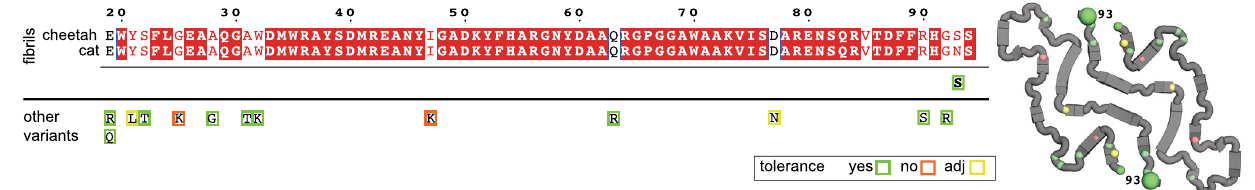
Fig. 5 | Cheetah and cat AA amyloid are 99% identical. Sequence alignment of extracted cat and cheetah amyloid (Q1T770 and B0M1H2) identi fi ed in this and a previous study 39 . Sequence conservation is based on a multiple sequence alignment 90,92 comprising ten cat and cheetah SAA variants (A0A2I2UCY9, A0A6J2AHC5, A0A337S9A8, A0A337SUS3, A0A6J2AJW0, M3WHE0, A0A5F5XYT5, A0A337SKP2). Single-residue substitutions are highlighted on sequence (left) and